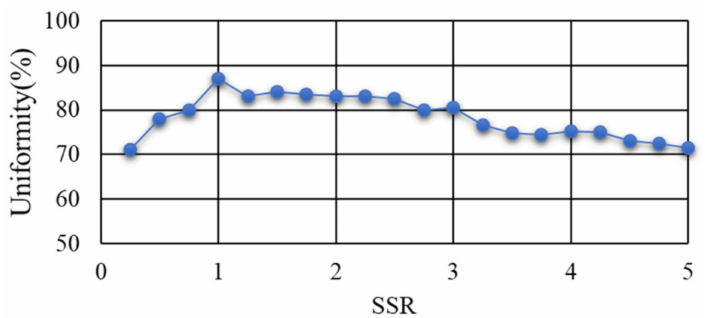
Figure 14. Variation curve of uniformity with the SSR.